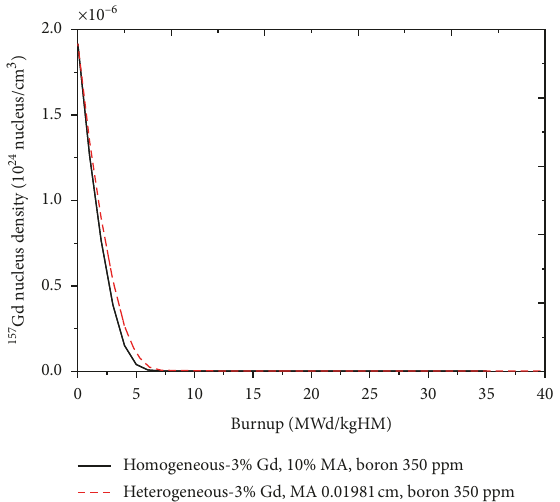
Figure 23: Comparison of the depletion of 157 Gd for two MA loading